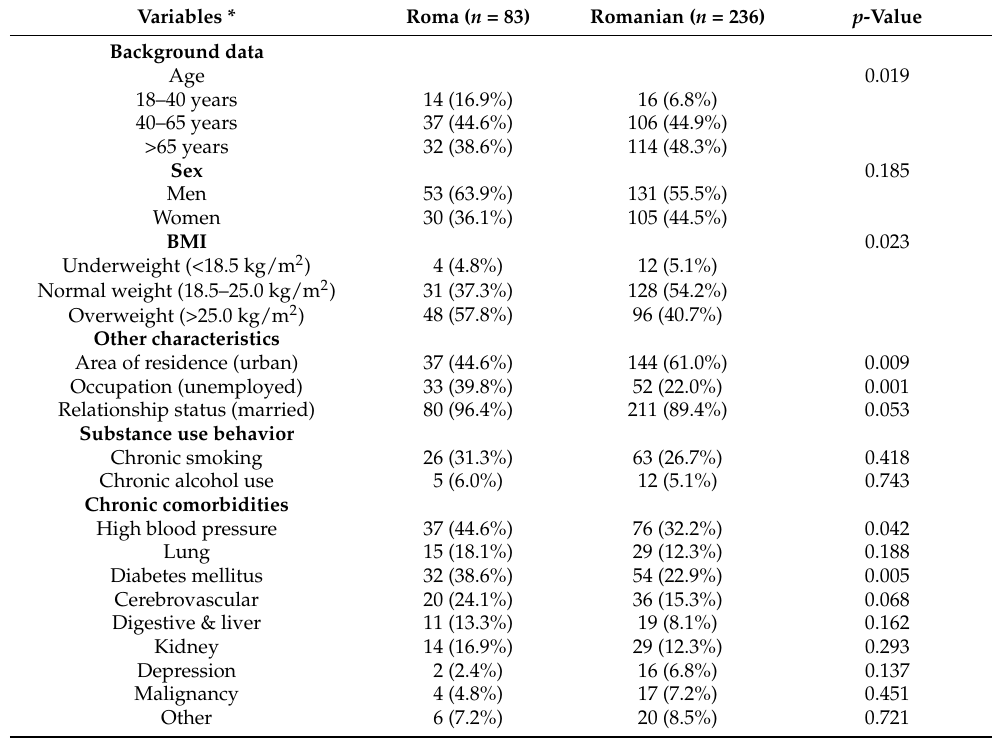
Table 1. Comparison of baseline characteristics between patients of Roma and Romanian ethnicity with severe